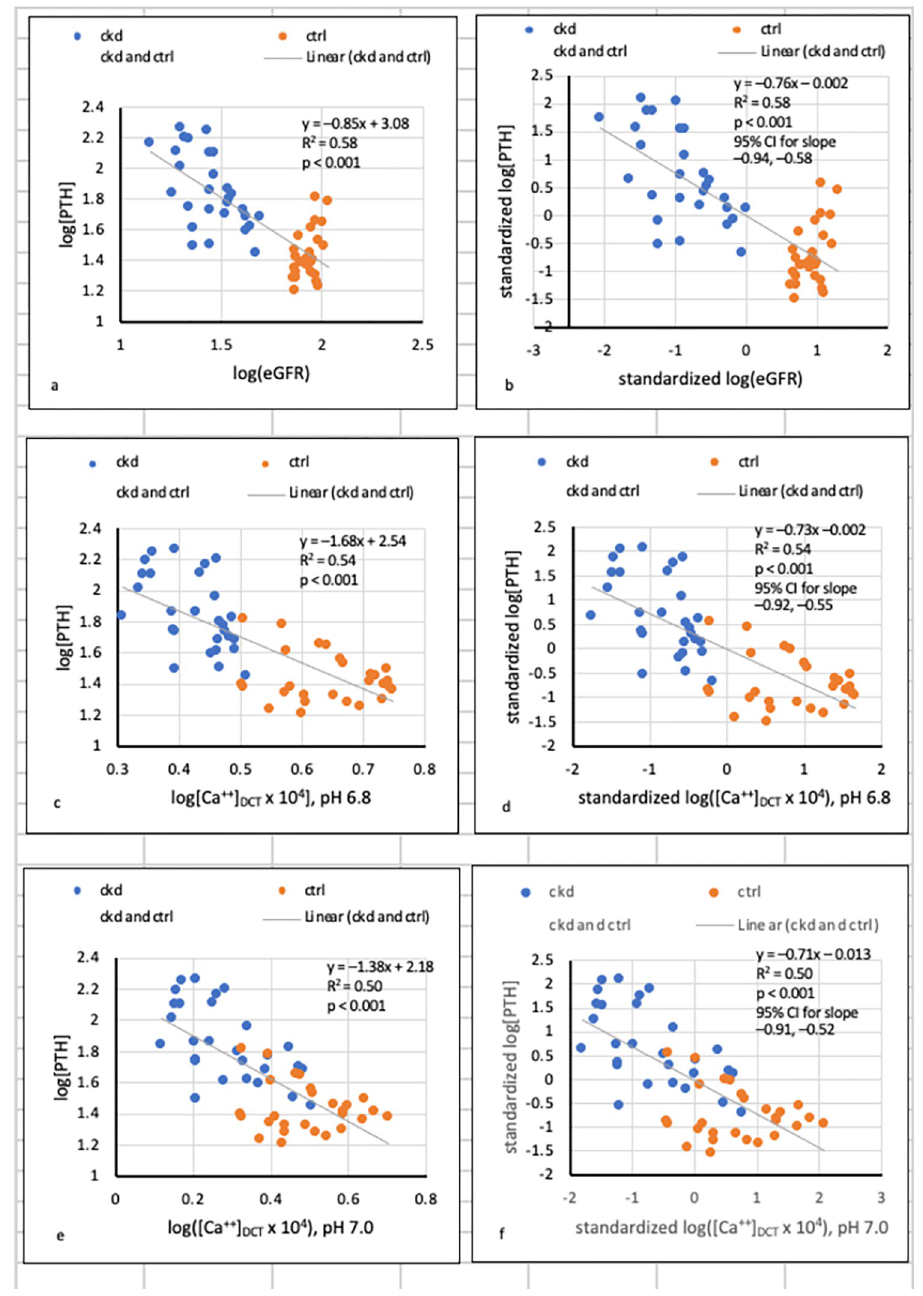
Fig 5. Regressions of [PTH] on eGFR and [Ca ++ ] DCT after log-transformation of variables and standardization of logarithmic